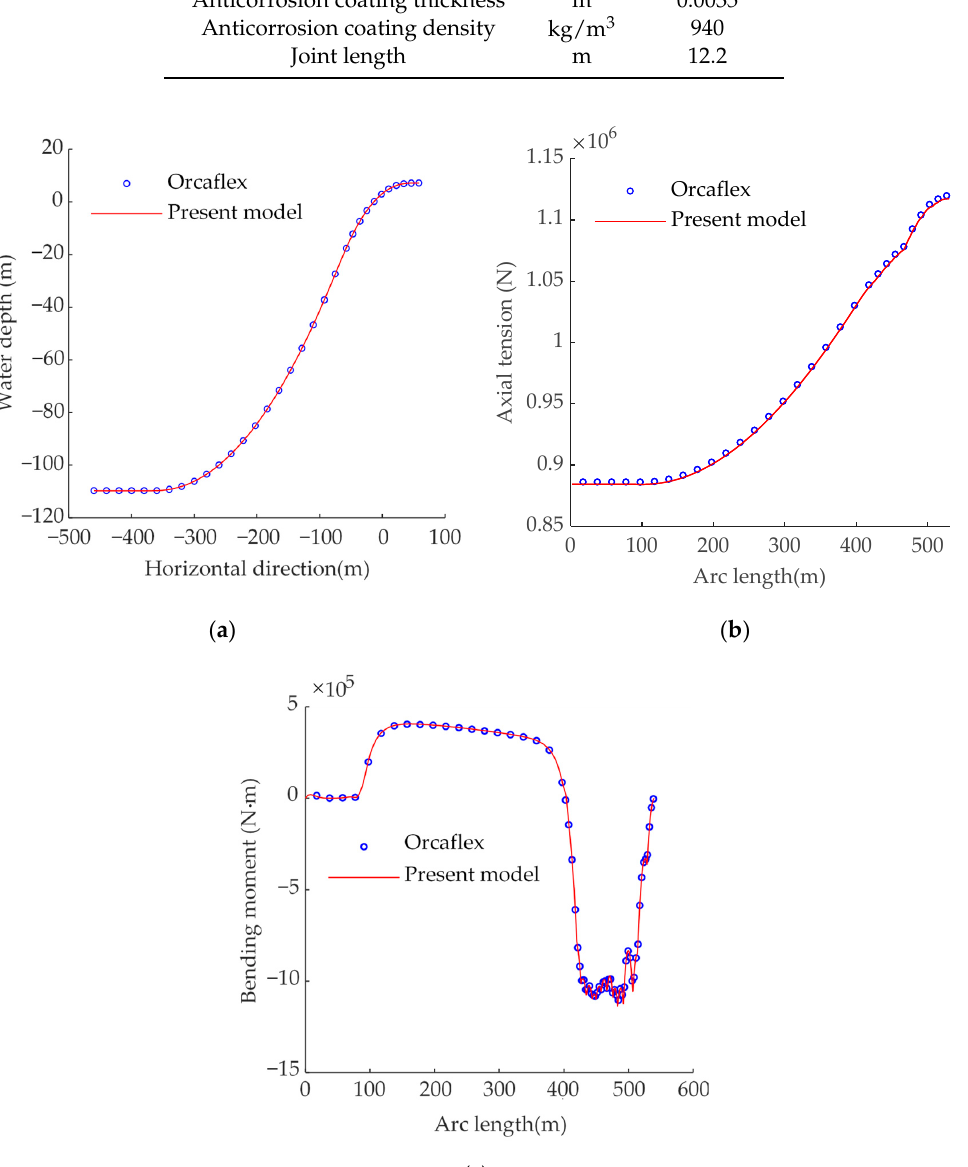
Figure 10. Comparison between the present model results and OrcaFlex simulations: ( a ) configurations; ( b ) tension forces; and ( c ) bending moments.